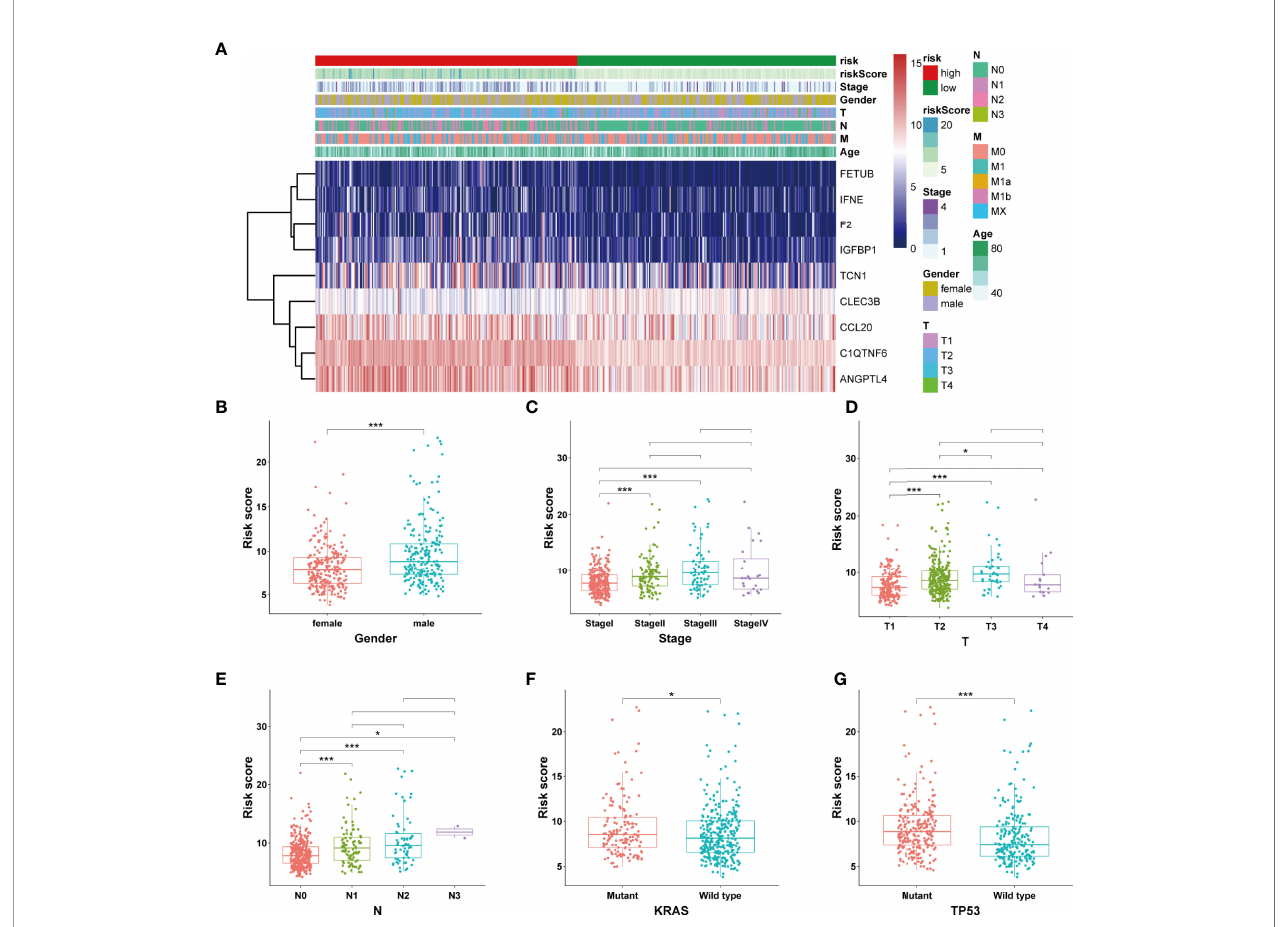
FIGURE 4 | Estimation of the correlation between the SPRrisk and different clinicopathological features. (A) Heat map showing the association of the expression levels of 9 selected secreted protein-related genes and clinicopathologic features. (B – G) The different levels of risk scores in lung adenocarcinoma patients were strati fi ed by gender, clinical stage, T stages, N stages, KRAS mutation status, and TP53 mutation status. * P < 0.05, *** P <